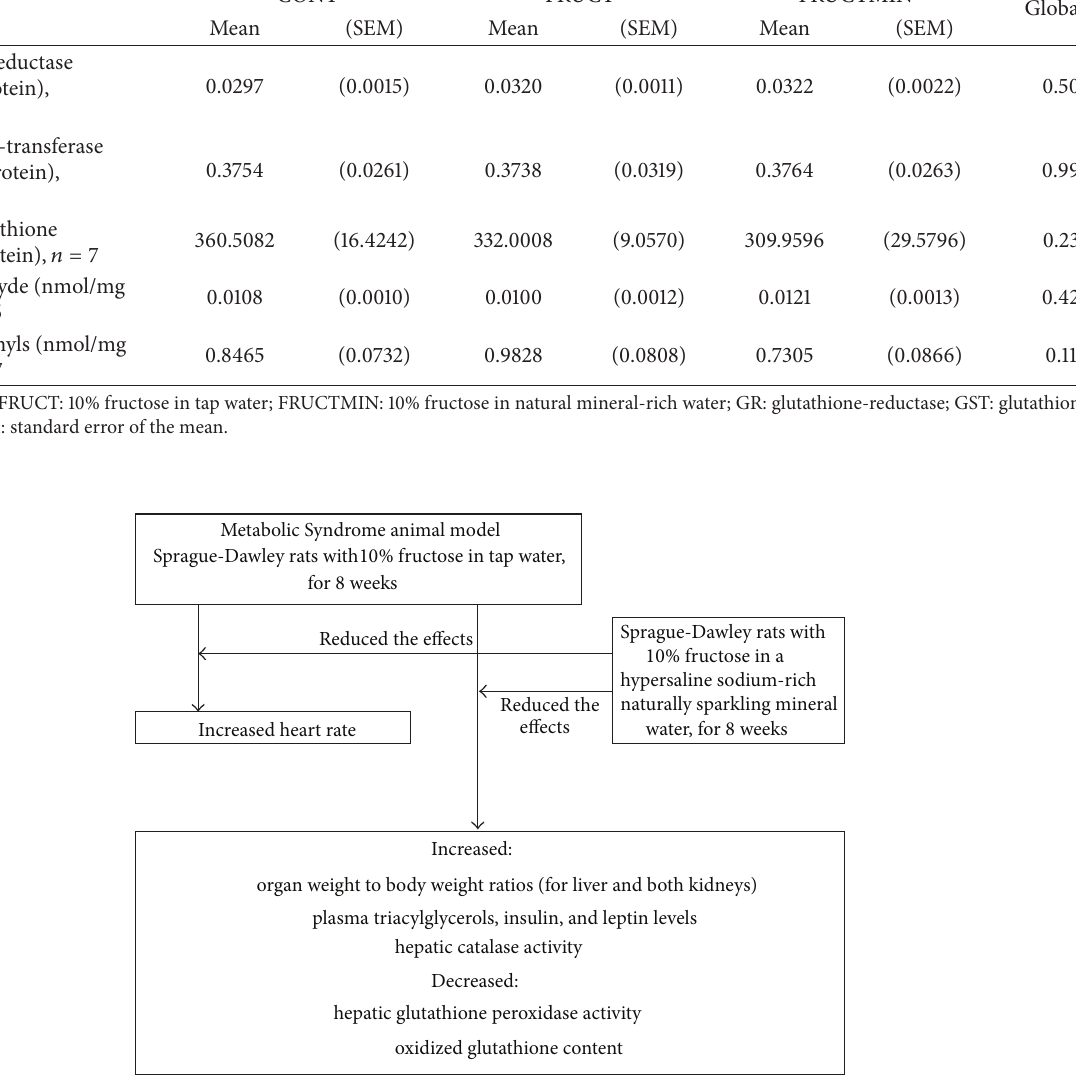
Figure 9: Summary of fructose-feeding effects that were reduced/prevented by the natural mineral-rich water.